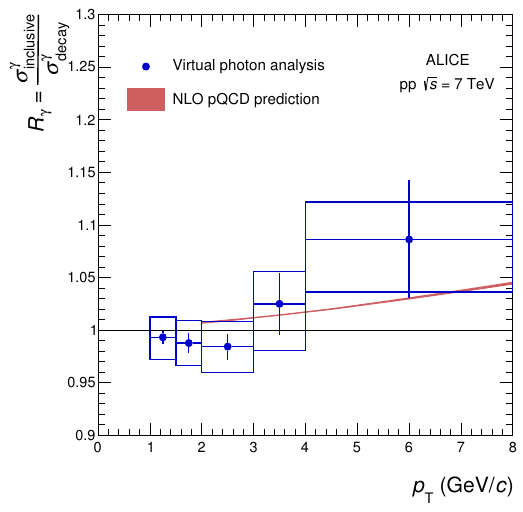
Figure 18 . Ratio of inclusive to decay photon cross sections extracted from the dielectron spectra p measured in pp collisions at s = 7 TeV. The results are compared with NLO pQCD calcula- tions [102{105]. Statistical and systematic uncertainties are shown as vertical bars and boxes for the data, respectively, and as a band for the NLO pQCD